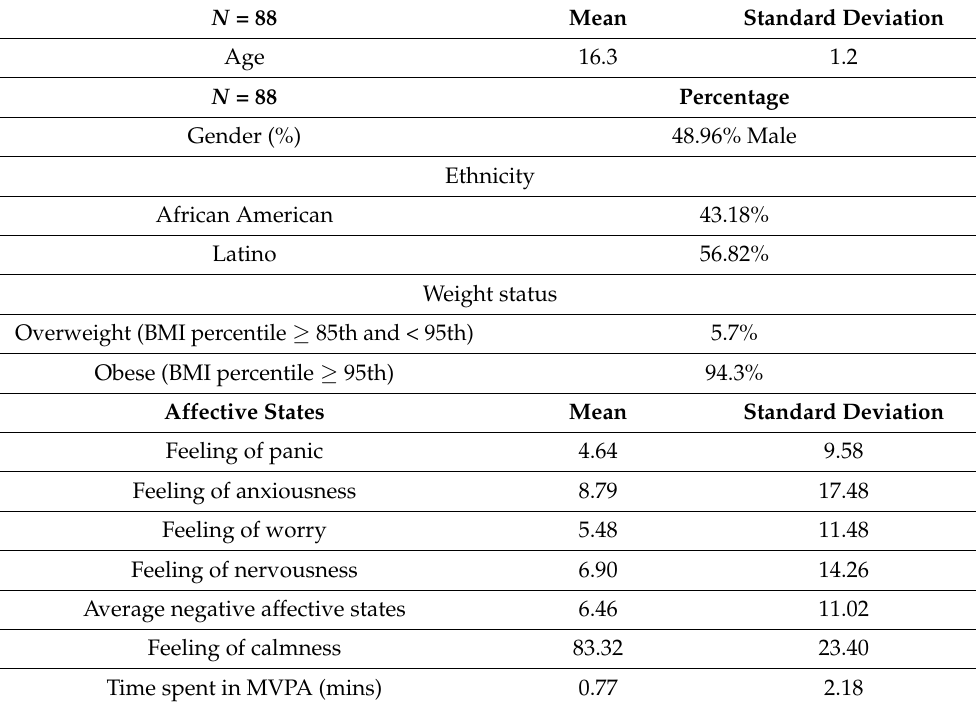
Table 1. Descriptive statistics of the study participants, affective states, and time spent in MVPA. N = 88 Mean Standard Deviation Age 16.3 1.2 N = 88 Percentage Gender (%) 48.96% Male Ethnicity African American 43.18% Latino 56.82% Weight status Overweight (BMI percentile ≥ 85th and <